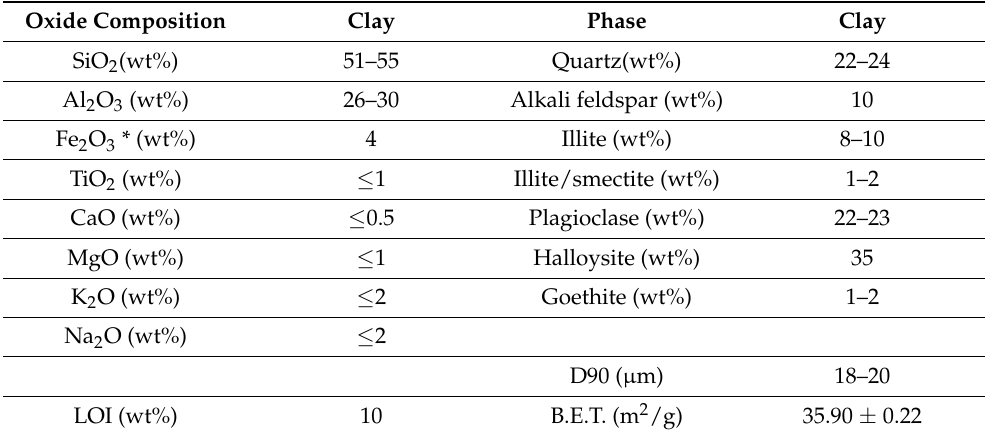
Table 2. Chemical (XRF) and mineralogical (XRD) compositional range of clay (* Iron Ox- ides/hydroxides expressed as F 2 O 3